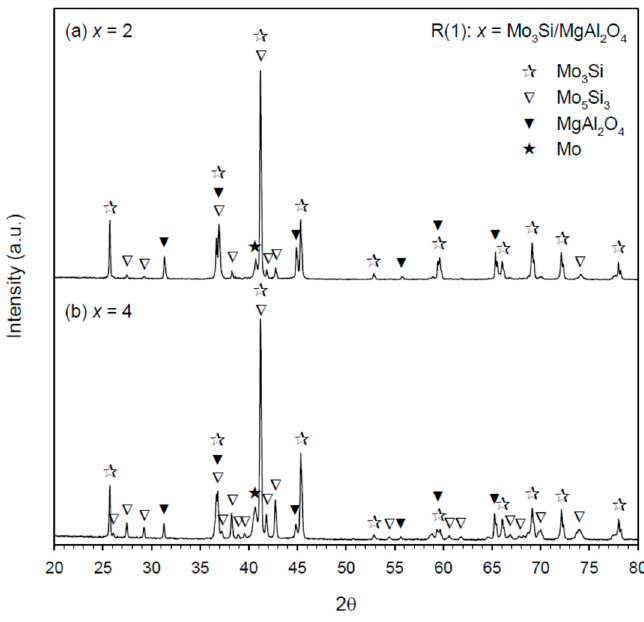
Figure 5. XRD patterns of as-synthesized Mo 3 Si–MgAl 2 O 4 composites from R(1) with ( a ) x = 2 and ( b ) x = 4.